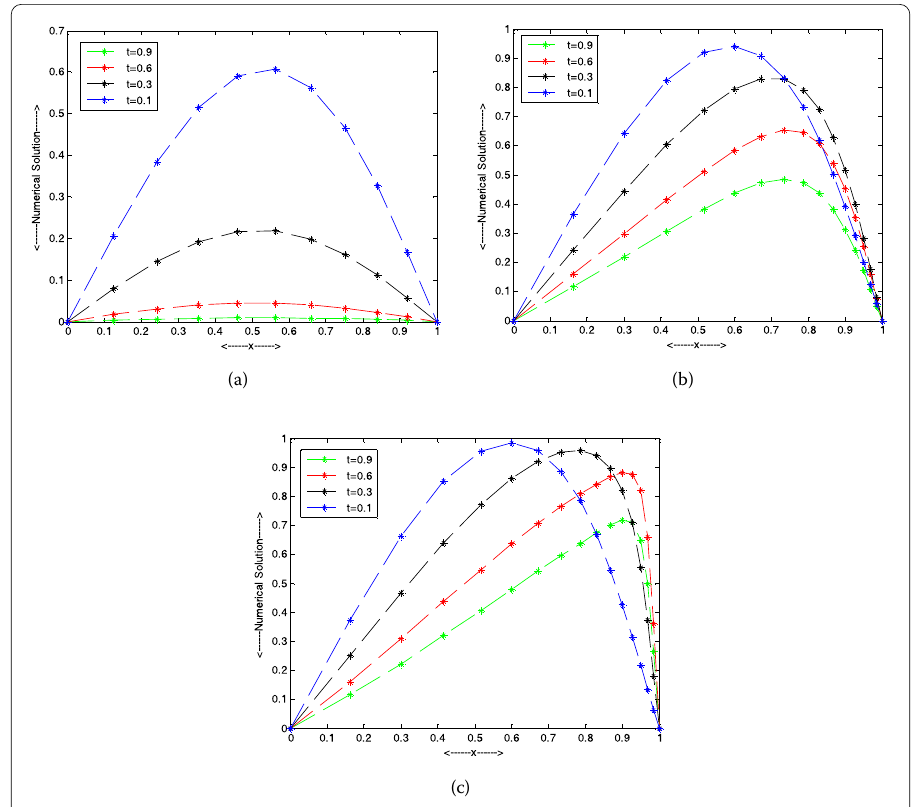
Figure 3 Example 5: Computed solutions for different time levels. (a) ε = 2 –1 , (b) ε = 2 –4 , (c) ε = 2 –6 .